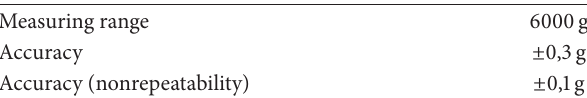
Table 2: KERN PCB 6000-1 scale technical data [9].